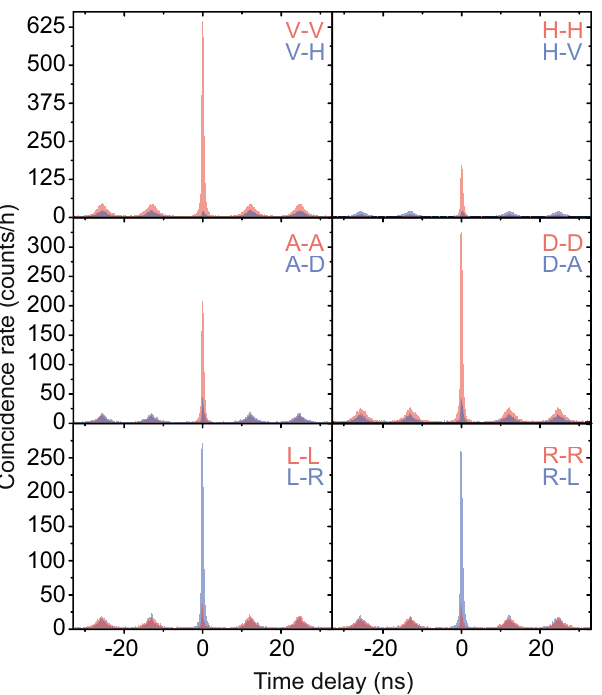
Figure 5. Twelve cross-correlation measurements between the biexciton and exciton for different polarization detection bases, from top to bottom: rectilinear, diagonal and circular basis. The first (second) letter in the graphs stands for the polarization detection angle of the biexciton (exciton). The fidelity to the + ( HH VV )/ 2 state is F = 0.817 ± 0.002 without temporal post-selection. These measurements are used to extract the Bell parameters in three orthogonal planes of the Poincaré sphere, given in Table